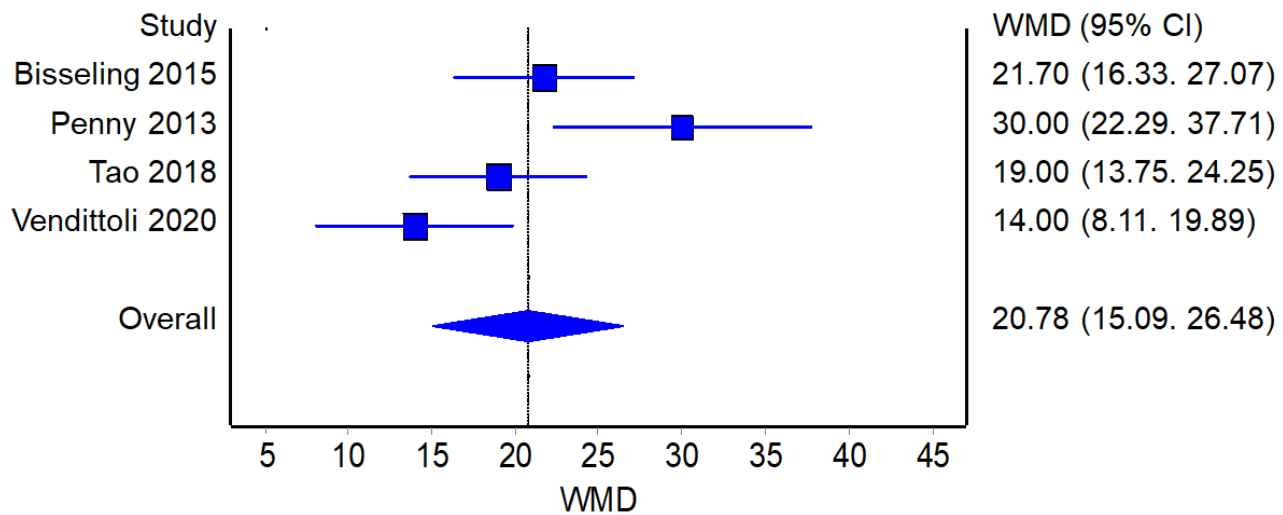
Figure 6. Operative Time: Forest plot of the individual studies and pooled mean difference for operative time, including a 95% confidence interval. The size of the squares shows the weight of the study